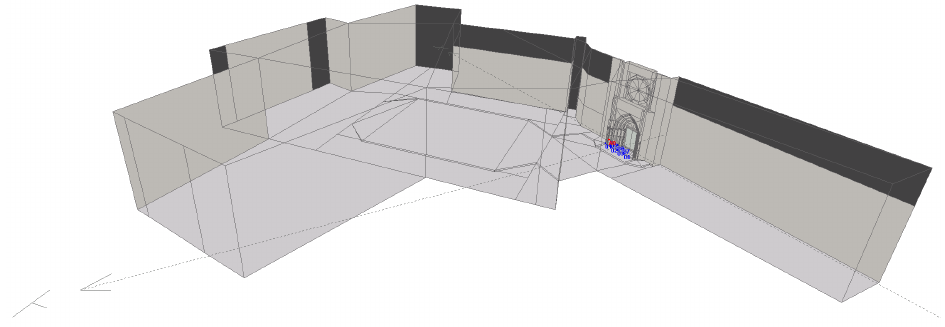
Figure 2. Virtual model used in the acoustic simulation of the soundscape of the Water